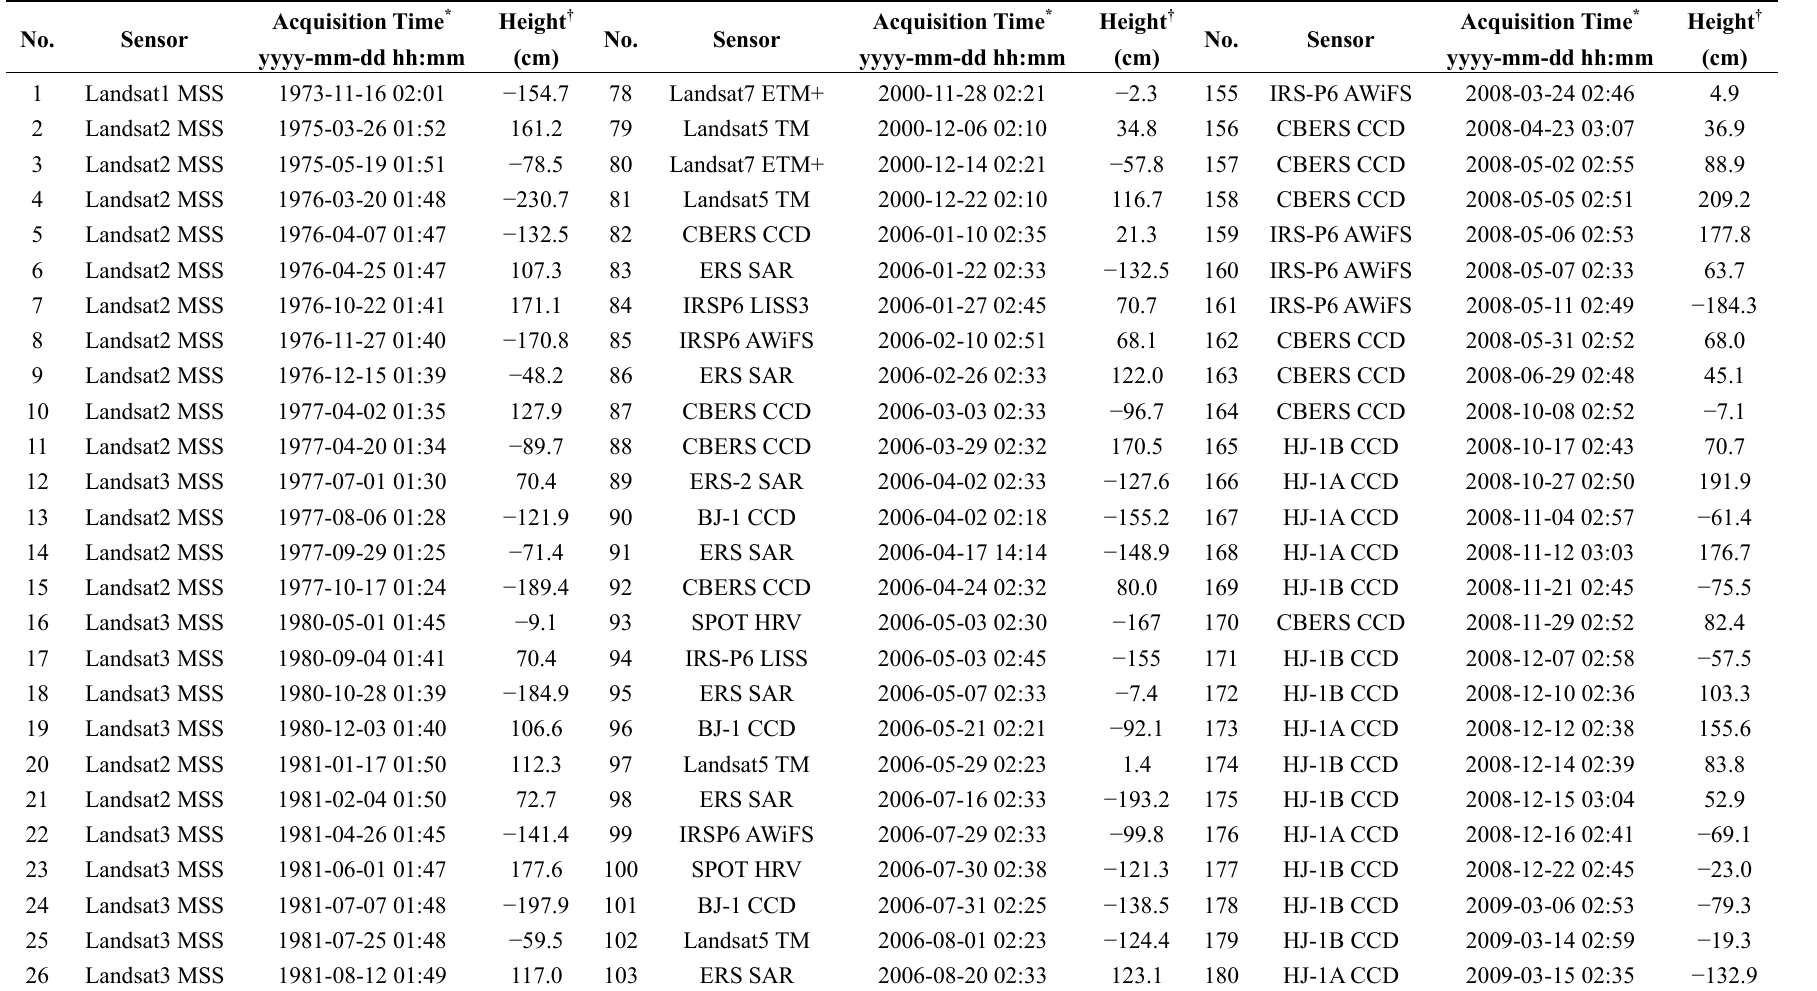
Table 2. Summary of the medium-resolution satellite images used in this